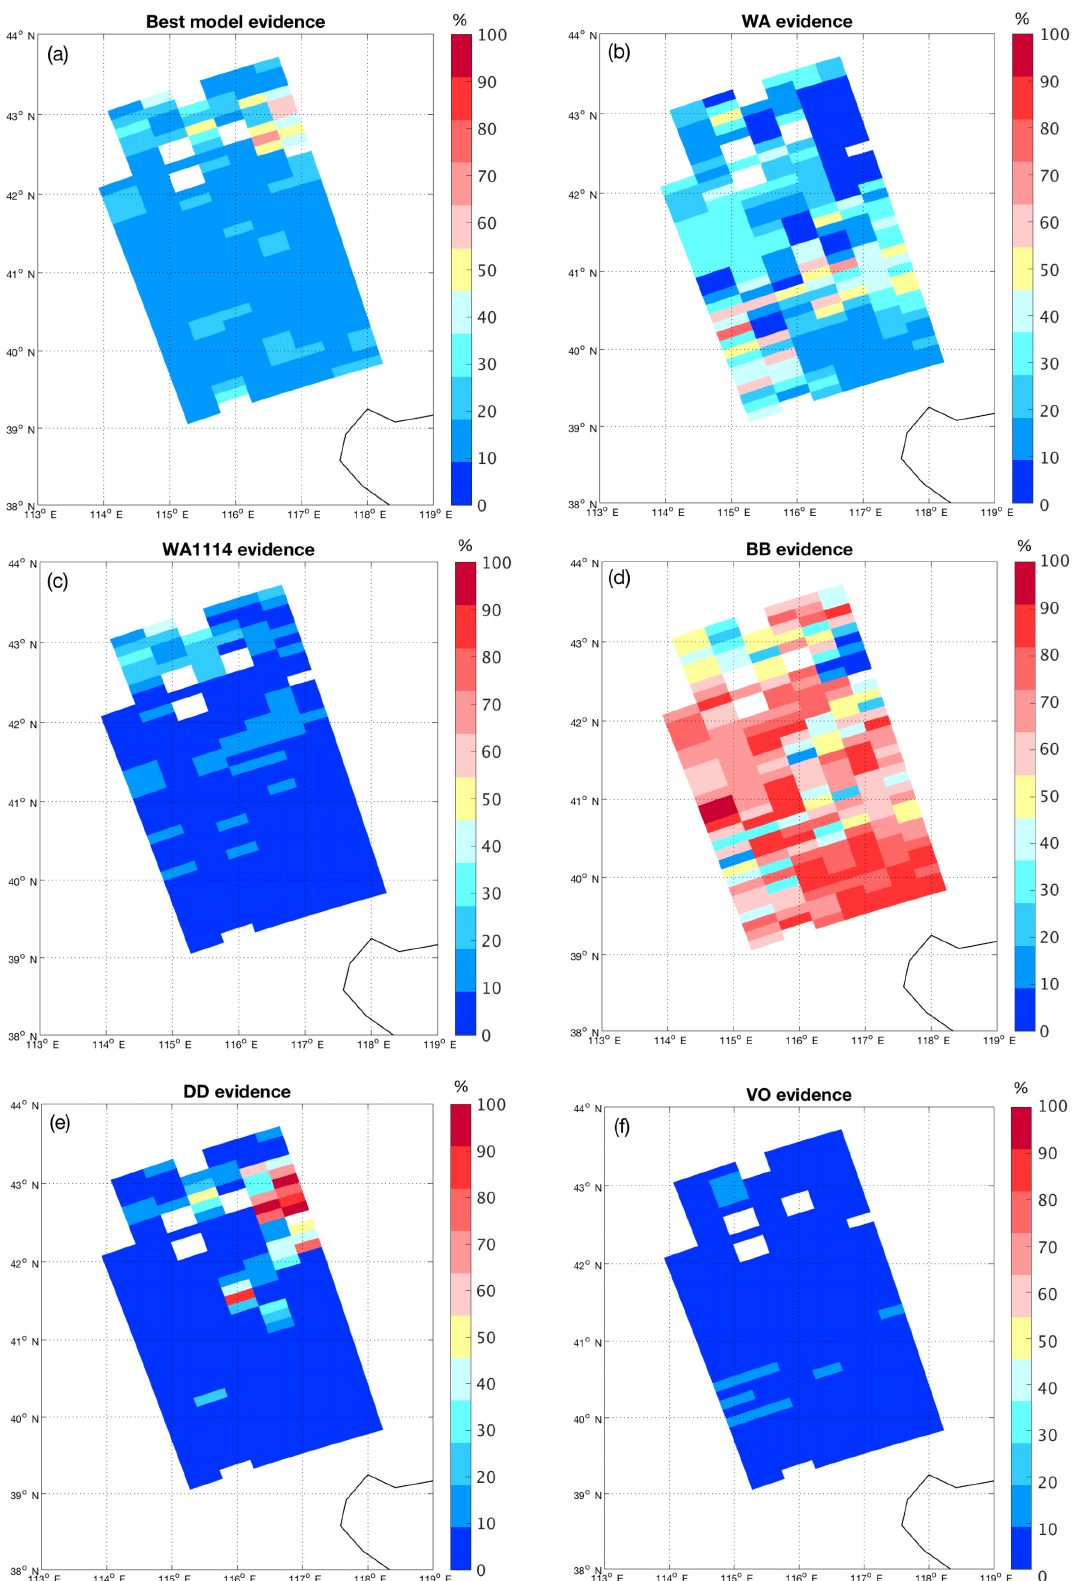
Figure 5. Same as Fig. 4 but showing the relative evidence distribution (%) of the selected best models on 27 April